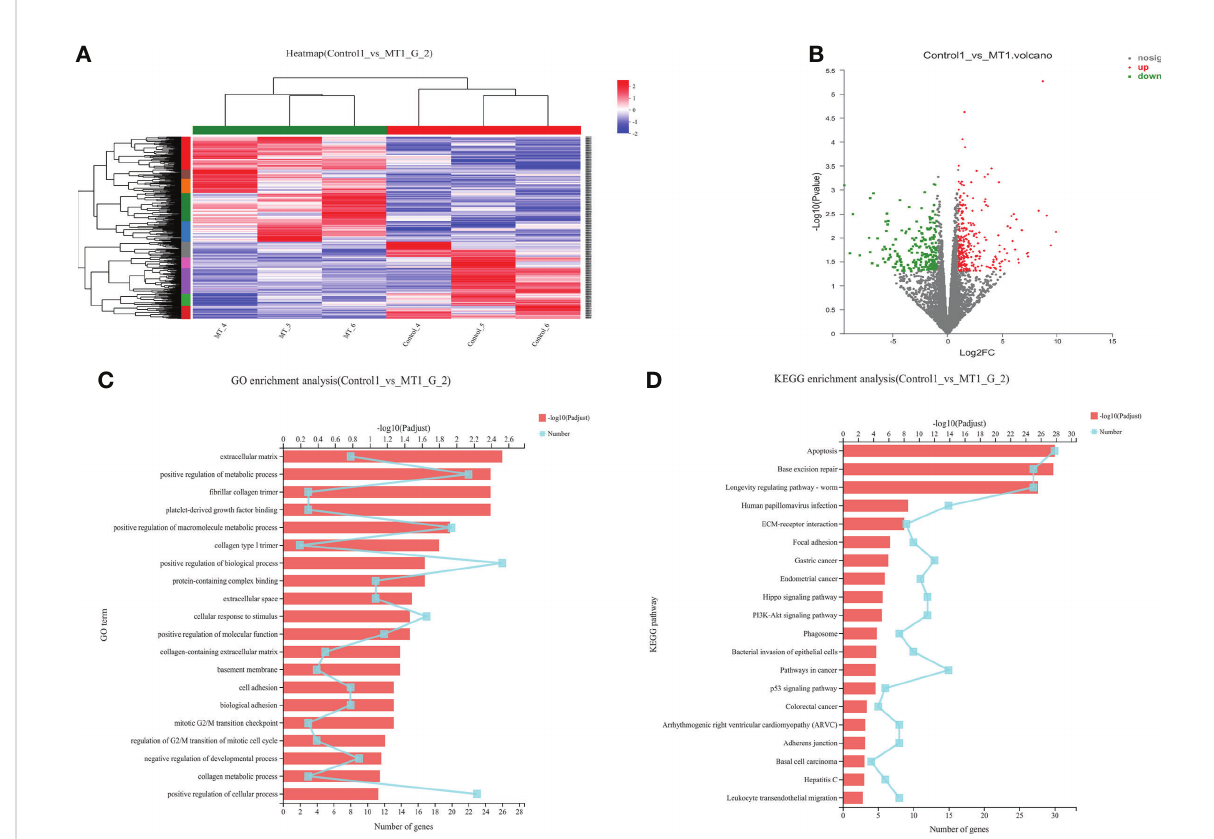
FIGURE 7 Transcriptome sequencing of back muscle tissue. (A) Cluster analysis; (B) Expression difference analysis; (C) GO enrichment analysis; (D) KEGG enrichment